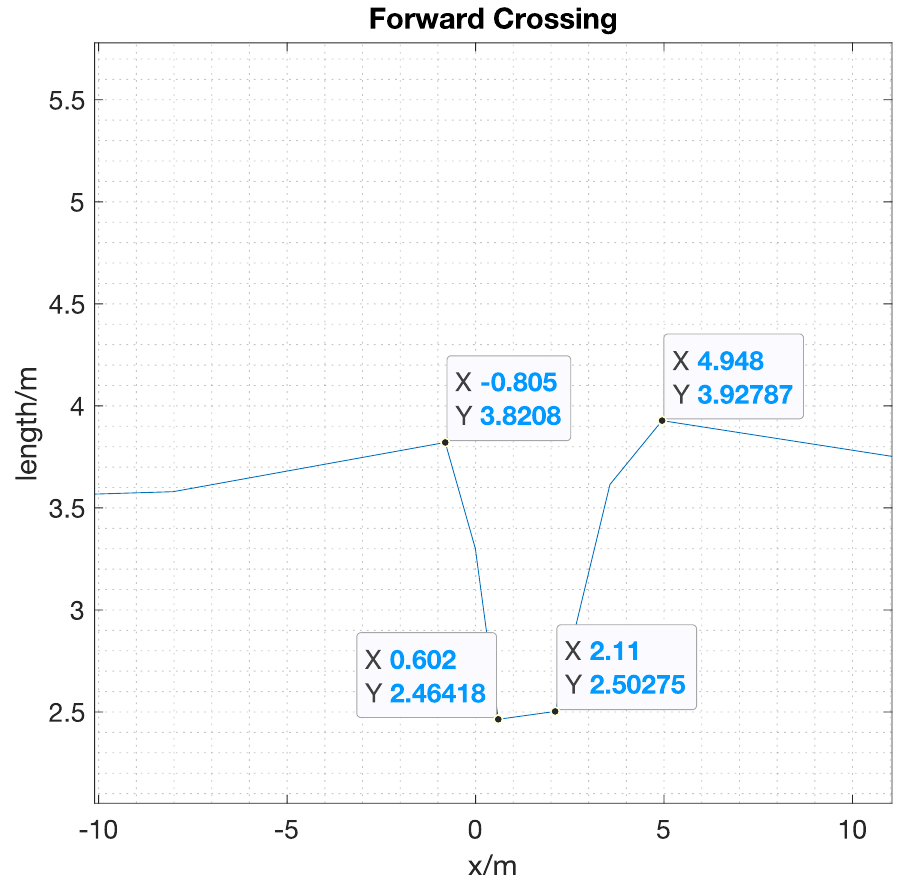
Figure 8. Change of vehicle length in a forward